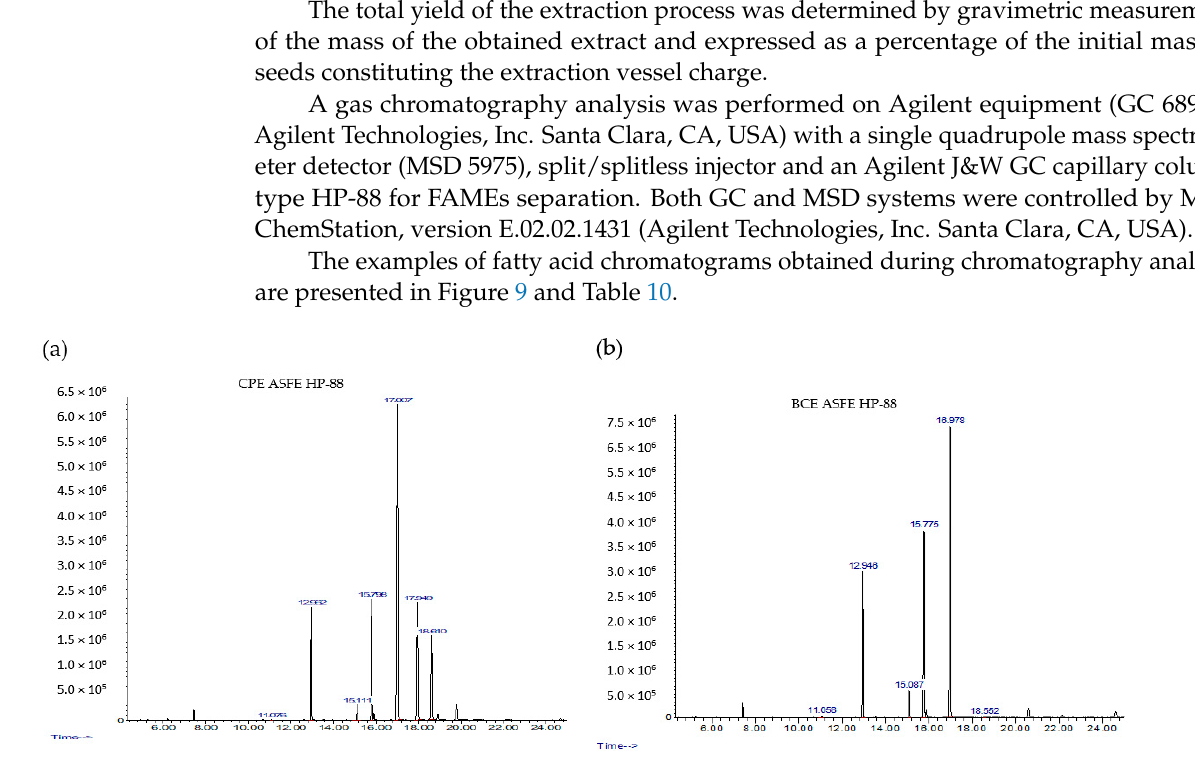
Figure 9. Chromatograms of FAs in blackcurrant ( a ) and black cumin ( b ) extracts. Table 10. Fatty acids determined during chromatography